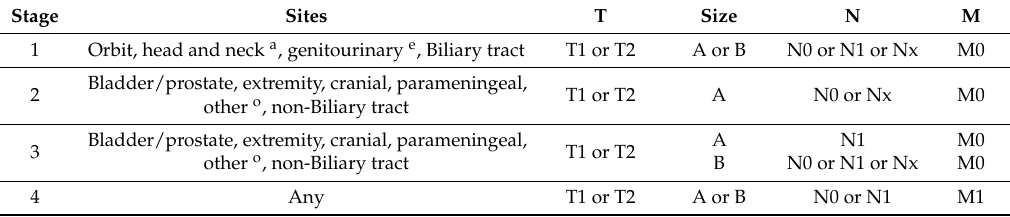
Table 1. Pretreatment Staging.